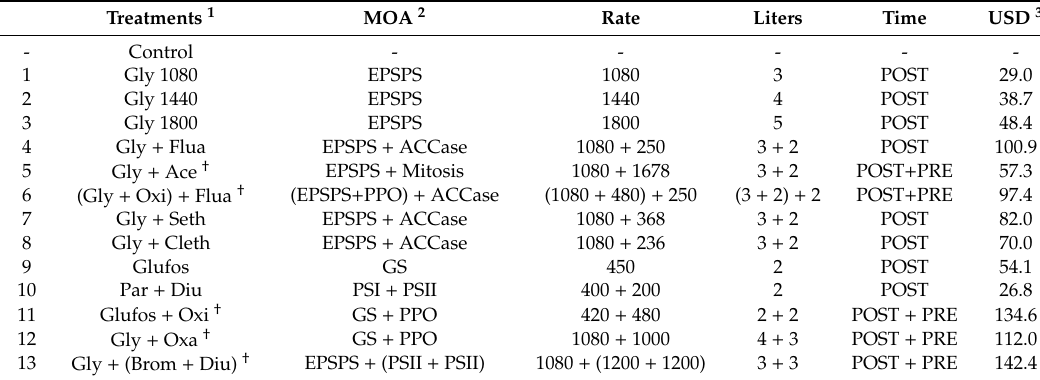
Table 1. Herbicides (Treatments), mechanism of action (MOA), field rates in g ai or ea ha − 1 (Rate), liters of commercial herbicide ha − 1 (liters), application time (Time) of pre- (PRE) and post-emergence (POST) herbicides for the weed control in two Persian lime groves of the “San Manuel” Farm, Puebla, Mexico, and cost of each treatment ha − 1 (USD).